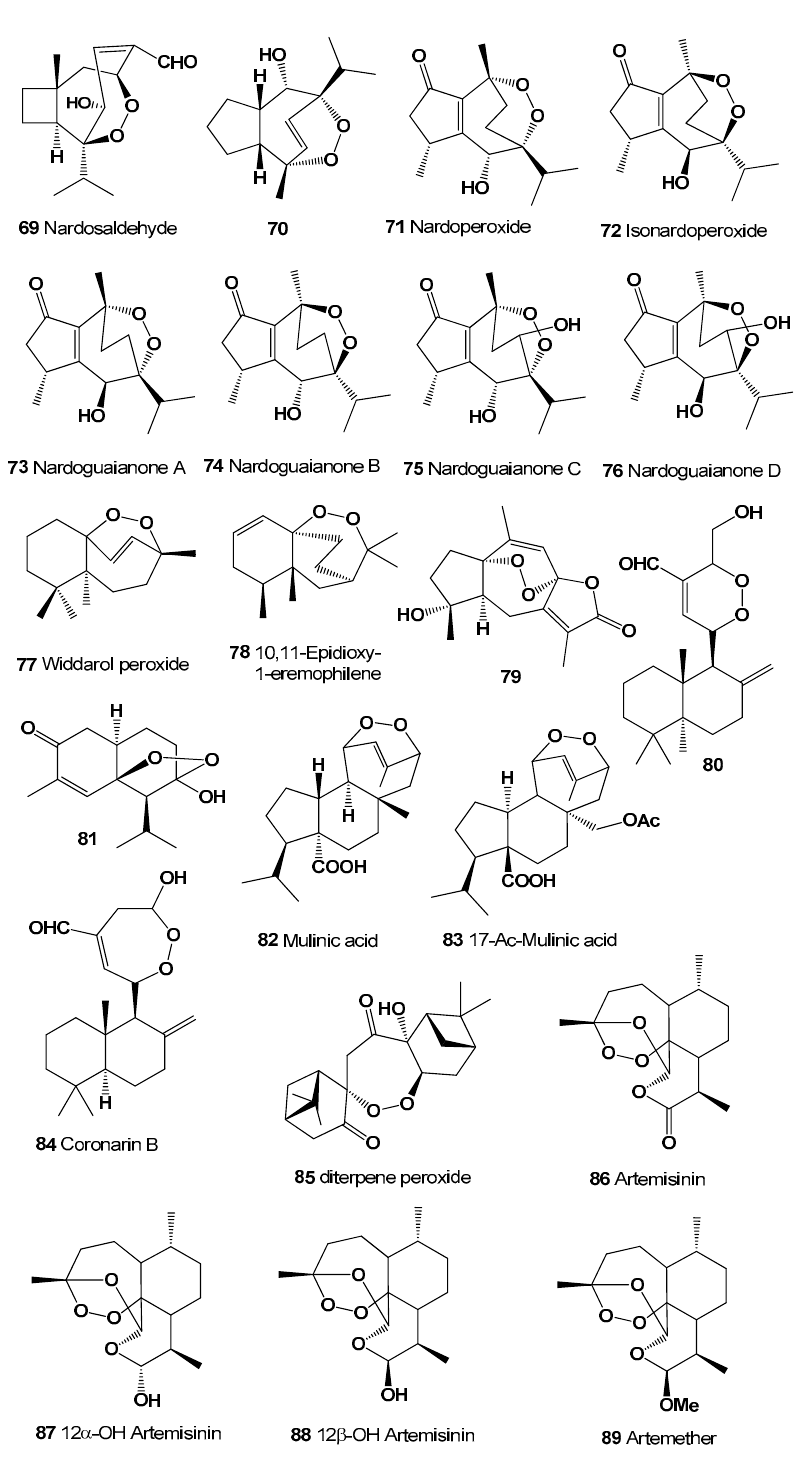
Figure 5. Bioactive polycyclic endoperoxides derived from plants.